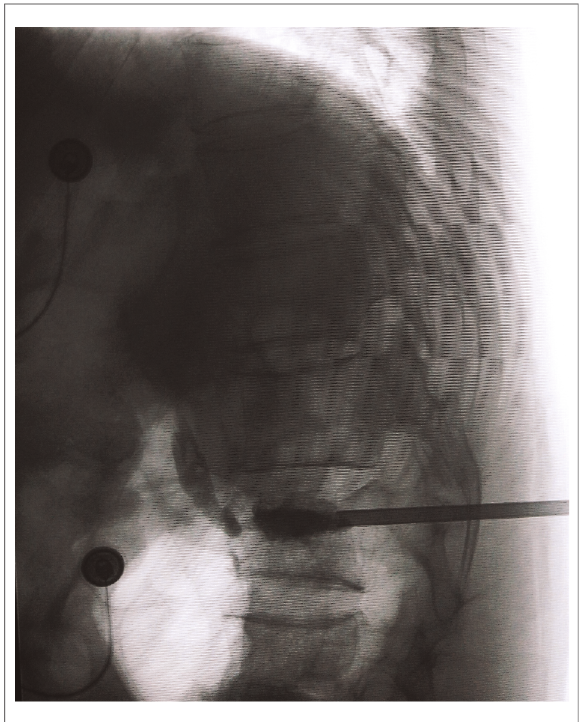
FIGURE 2 Intraoperative C-arm fl uoroscopy showed bone cement penetrating the anterior wall and leaking into the surrounding